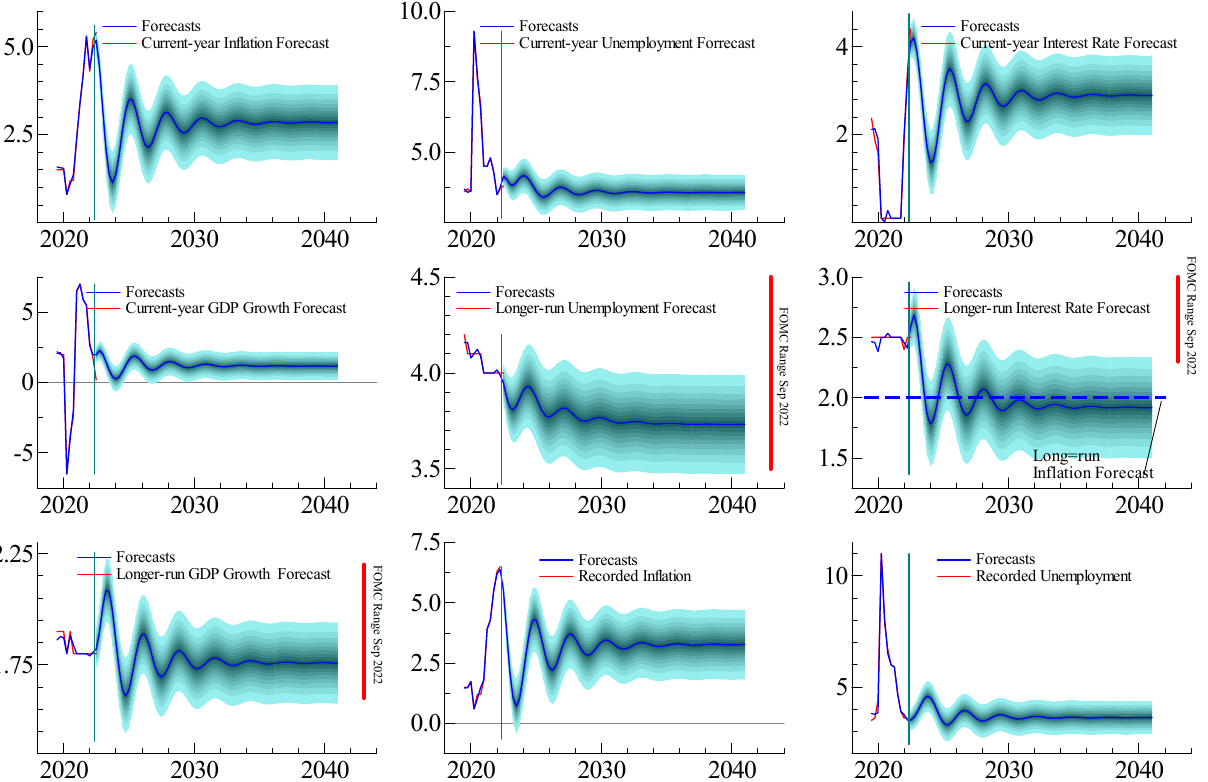
Figure 10. 95% confidence band for dynamic simulations of VAR, Equation (2): 2022: Q3 to 2040: Q4. Vertical red segments represent the range of the FOMC longer-run forecasts for September 2022. The shaded bands are the fan charts accounting for 95 percent probability.